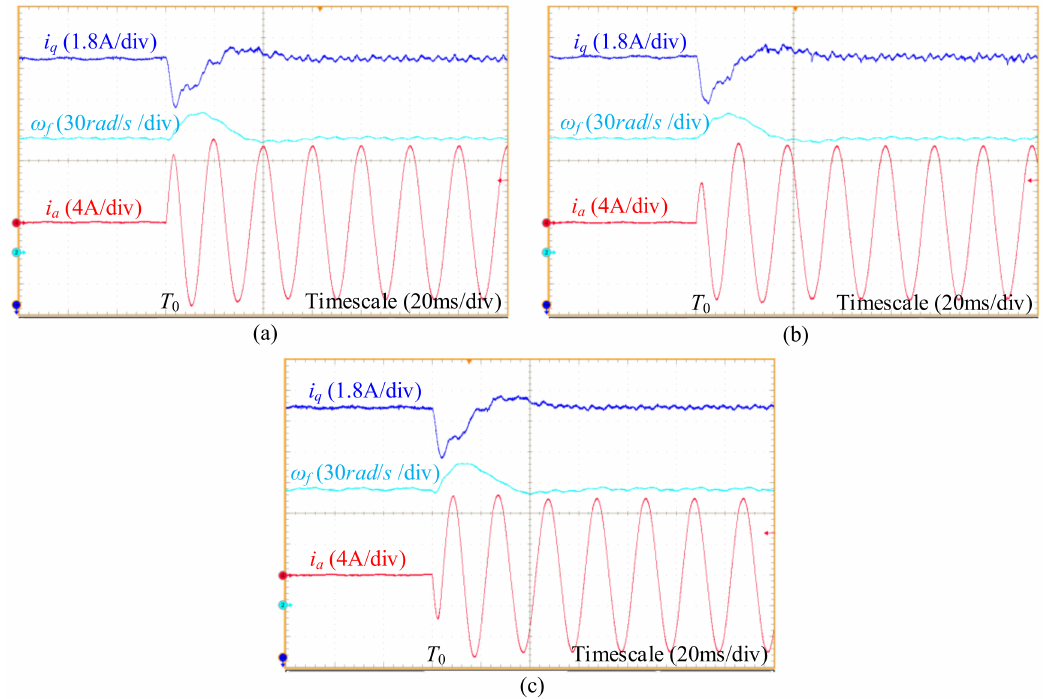
Figure 13. Dynamic responses of the converter using ( a ) implementation I; ( b ) implementation II; ( c ) implementation III of the adaptive resonance controllers with changing active current reference.